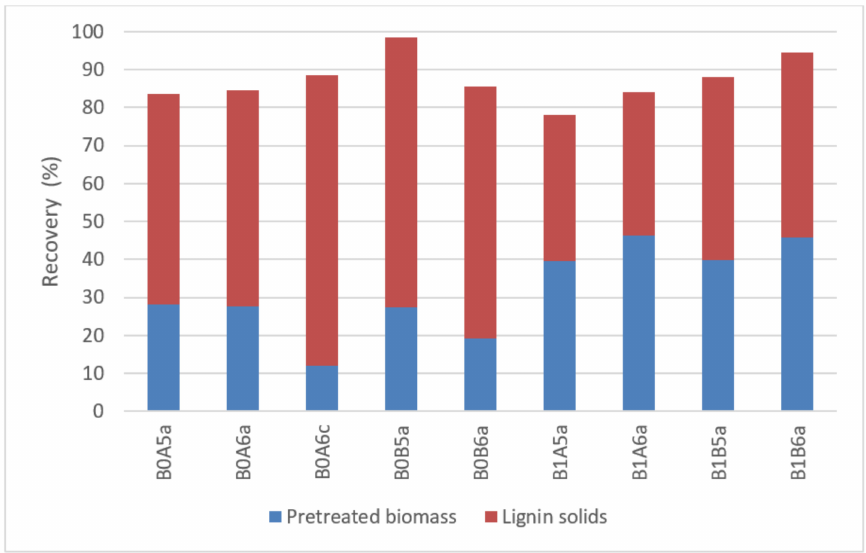
Figure 5. Lignin distribution in the different fractions. Representation of the codes: 0—pretreatment at 200 ◦ C; 1—pretreatment at 180 ◦ C; A—pretreatment time of 15 min; B—pretreatment of 30 min; 5—50% v / v ethanol content; 6—60% v / v ethanol content; a—no catalyst added; c—1% w / w biomass H 2 SO 4